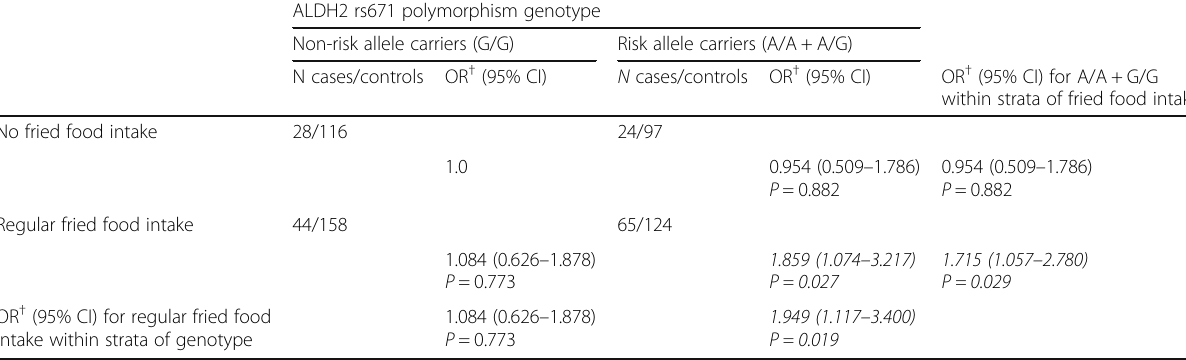
Table 4 Interaction between ALDH2 rs671 polymorphism and fried food intake on CAD risk ALDH2 rs671 polymorphism genotype Non-risk allele carriers (G/G) Risk allele carriers (A/A +